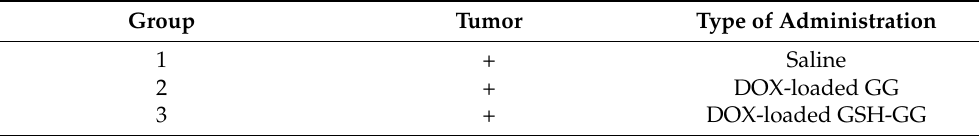
Table 2. Grouping of animal experimental mice. Group Tumor Type of